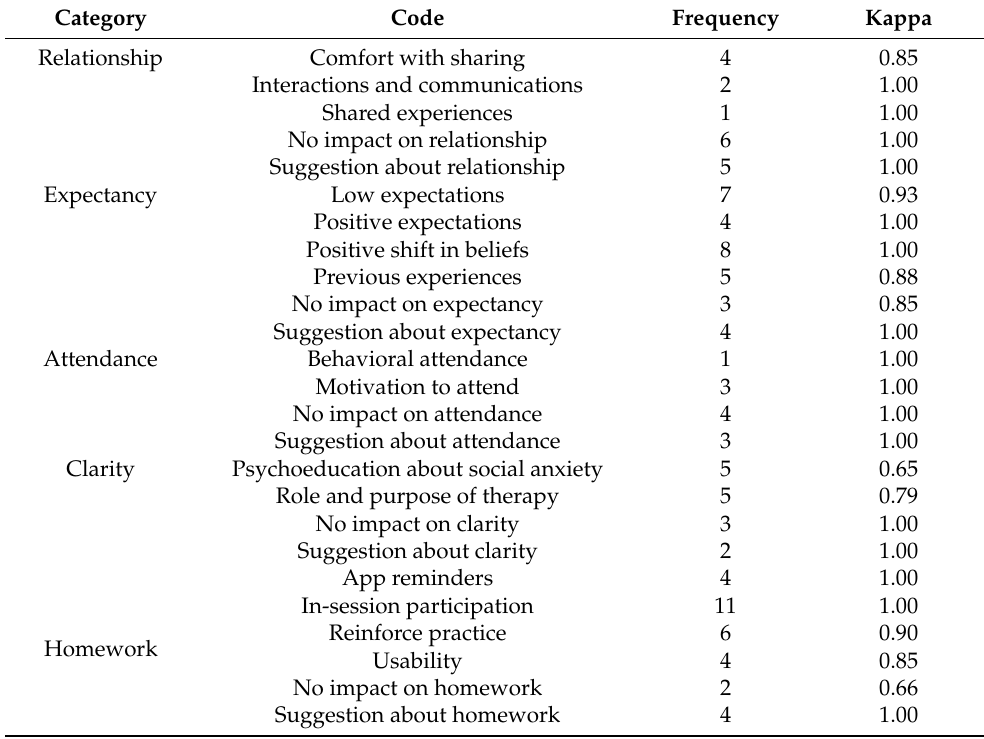
Table 1. Engagement codes by